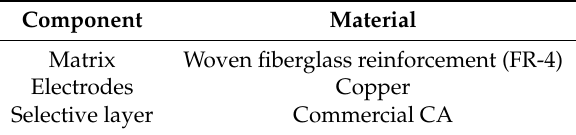
Table 3. Current materials.